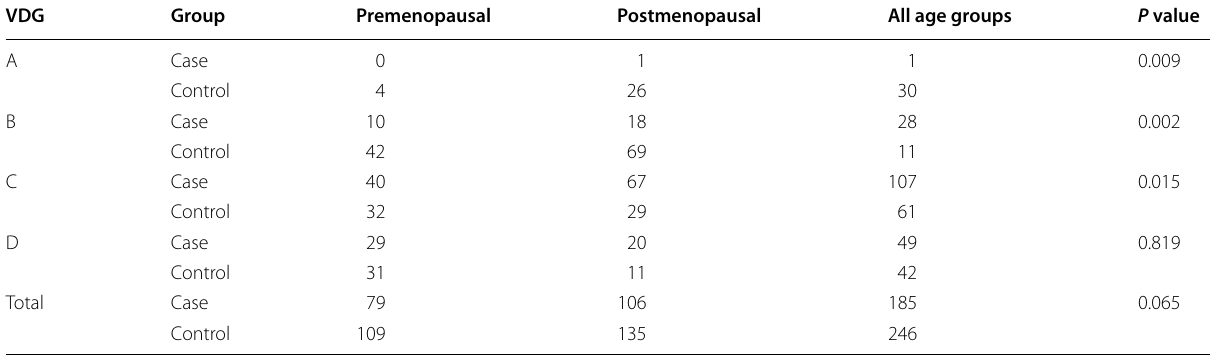
Table 2 Distribution of different volumetric density grades in case and control groups in premenopausal, postmenopausal and all age groups VDG